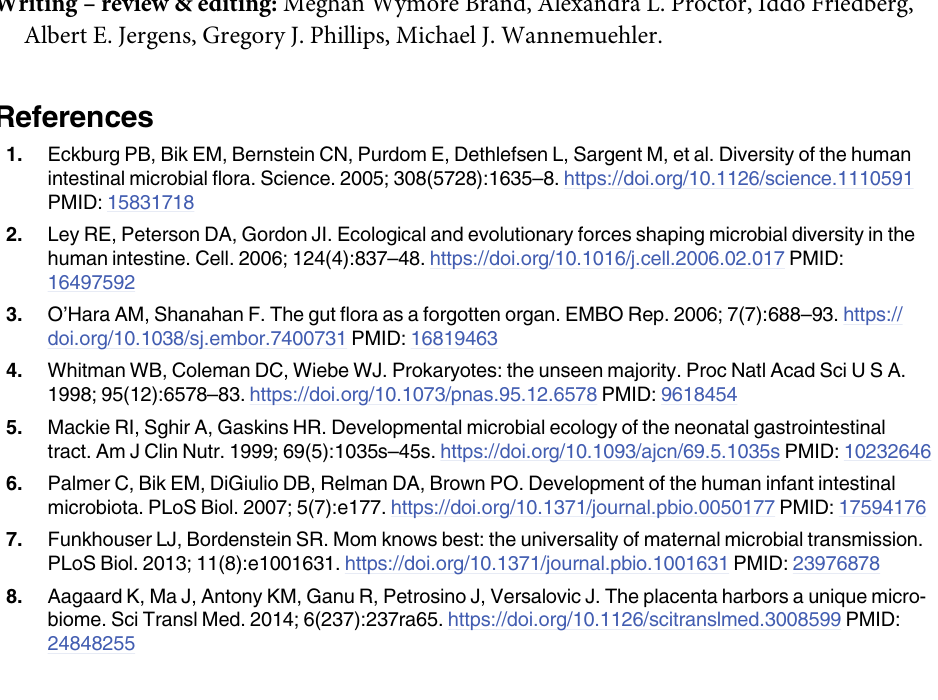
S3 Fig. Raw SAS outputs from analyses as described in materials &